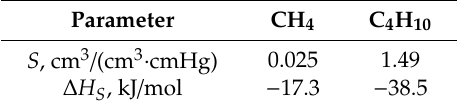
Table 2. Solubility parameters calculated for methane and butane in PMPentyne at 25 ◦ C [31].